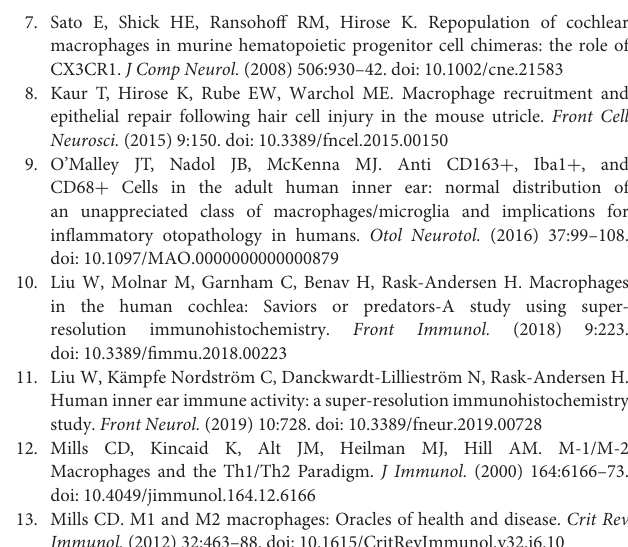
Supplementary Figure 2 | Confocal microscopy of fractalkine receptor (CX3CLR) expression in the human spiral ganglion. (A) Macrophages express both CX3CLR and MHCII. (B) Inset shows framed cell in higher magnification. (C) Macrophages express MHCII in spiral ganglion. (D) Same section as C shows that macrophages co-express MHCII and fractalkine